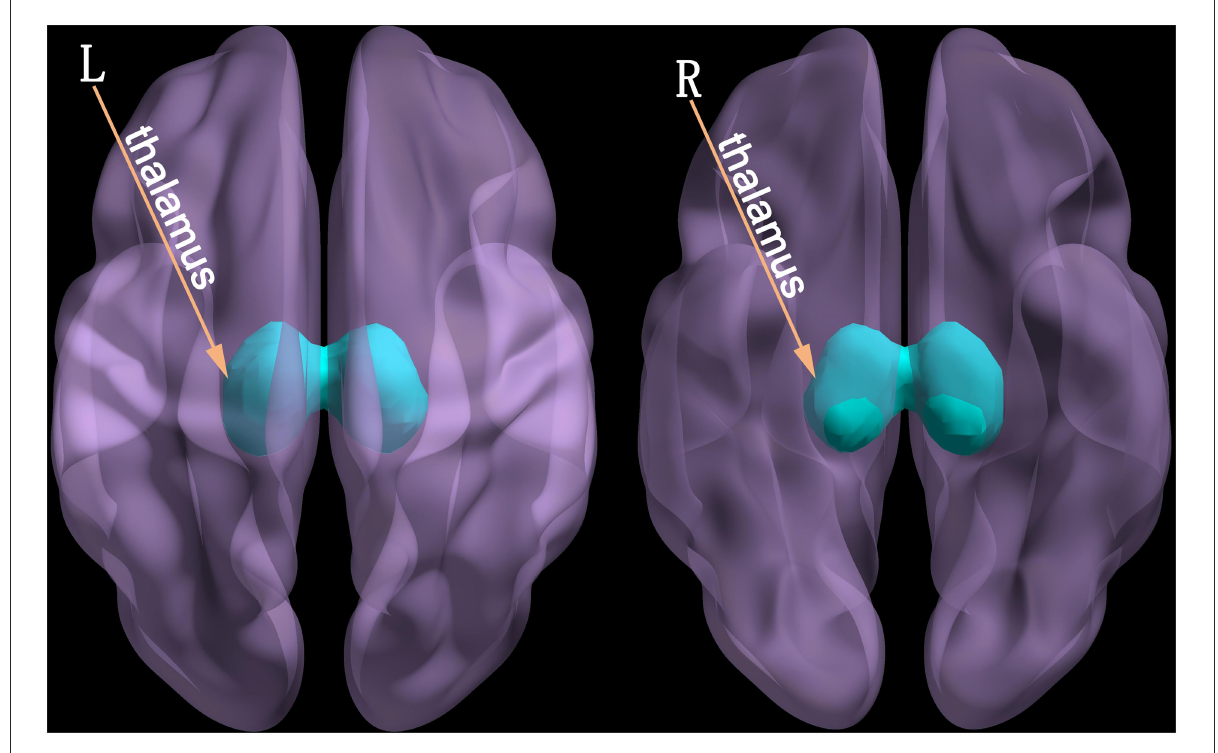
FIGURE1 The seed point for functional connectivity analysis - the thalamus (L, left; R,